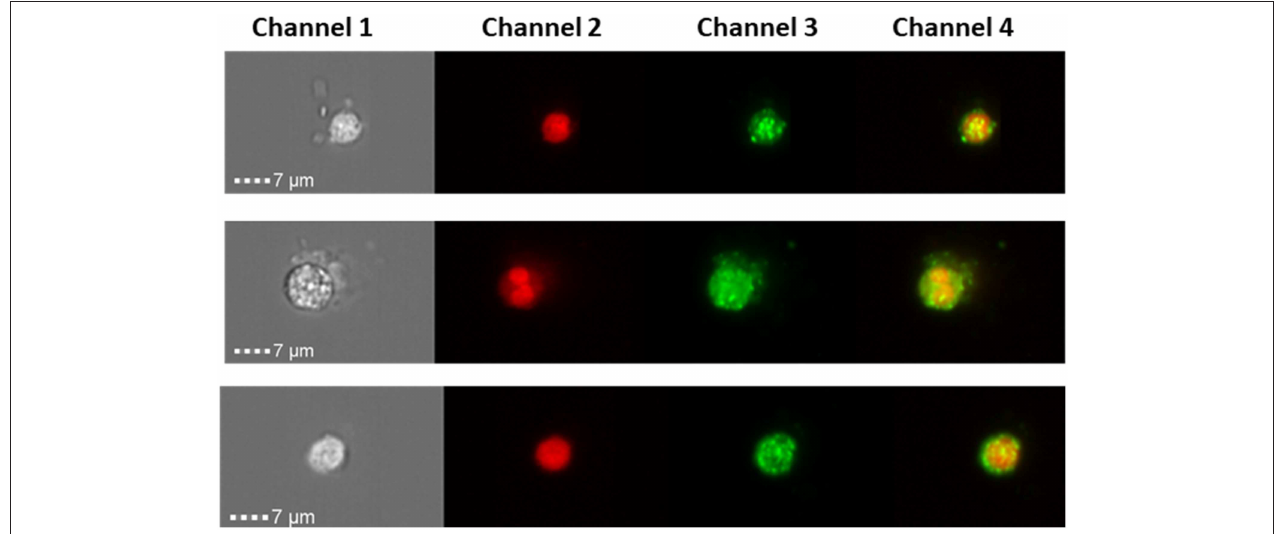
FIGURE 5 | ImageStream analysis showing expression SP-D in circulating tumor cells of 3 ovarian cancer patients, magnification x 40. Channel 1 shows the brightfield pictures of cells, channel 2 shows the nucleus stained with DRAQ5 (red), channel 3 shows SP-D expression using an Alexa Fluor ® secondary antibody (green) and channel 4 is the merged image of channels 1 and 2. SP-D is localized in the cytoplasm, with strong fluorescence